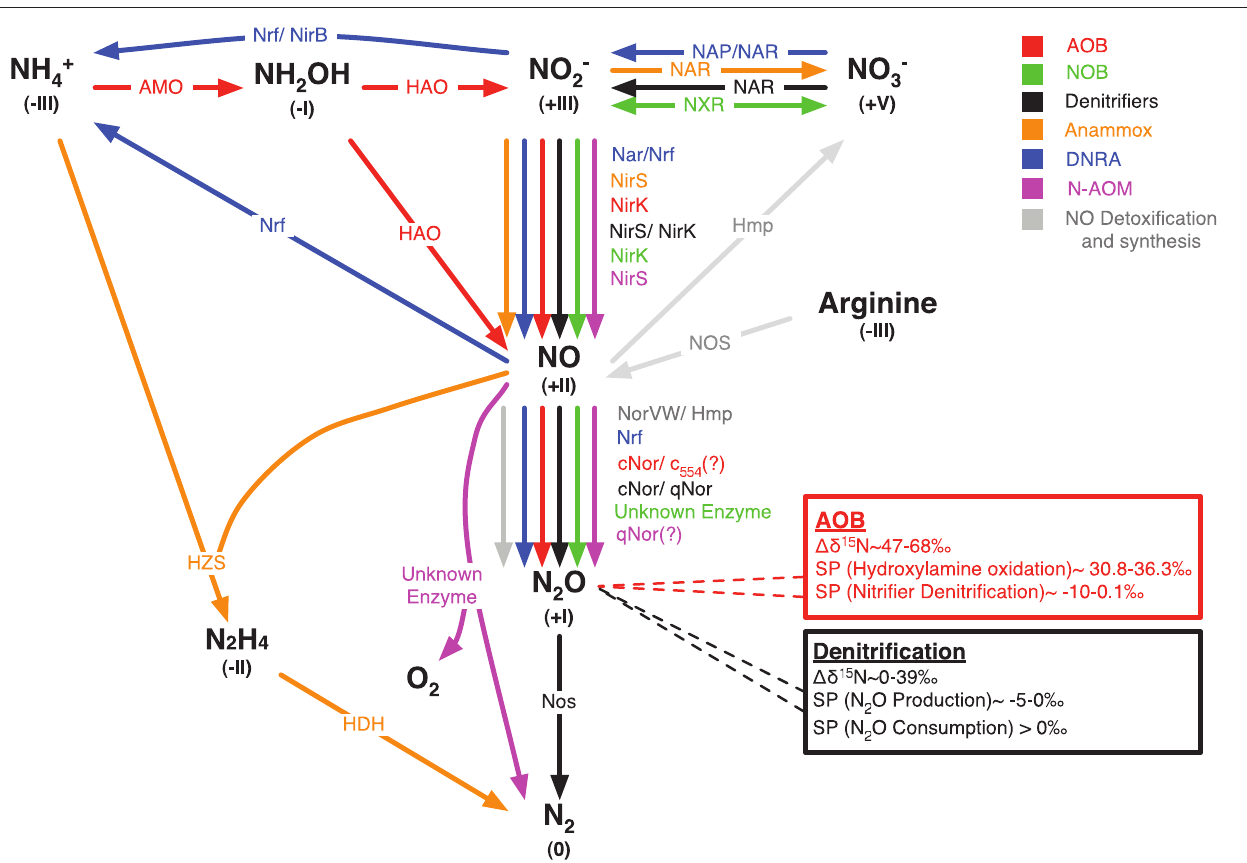
FIGURE 1 | Biological pathways for NO and N 2 O turnover in the catabolic branch of the N-cycle plus NO synthesis and detoxification. Different colors are allocated to different microbial guilds or turnover pathways: AOB (red), ammonia oxidizing bacteria; NOB (green), nitrite oxidizing bacteria; anammox (orange), anaerobic oxidation of ammonia; DNRA (blue), dissimilatory nitrate/nitrite reduction to ammonia; N-AOM (purple), oxygenic nitrite-dependent anaerobic oxidation of methane. Key enzymes of each microbial guild are depicted that are known to mediate the conversion from one chemical N-species into another: AMO, ammonia monooxygenase; HAO, hydroxylamine oxidoreductase; NXR, nitrite oxidoreductase; Nar, membrane-bound nitrate reductase; Nap, periplasmic nitrate reductase; NirK, copper-containing nitrite reductase; NirS,